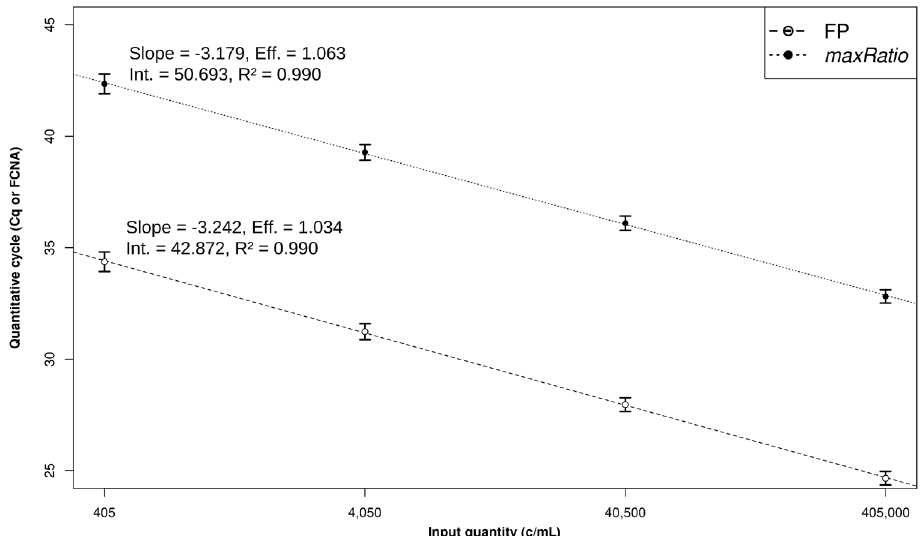
Figure 2. Linear models and CD quantification. Development of the linear models. The Cq ( ○ ) and FCNA ( ● ) were used to build SCs for FP (dashed line) and maxRatio (dotted line). The dots and bars represent the mean and standard deviation of the data, respectively. The characteristics of the models are reported.